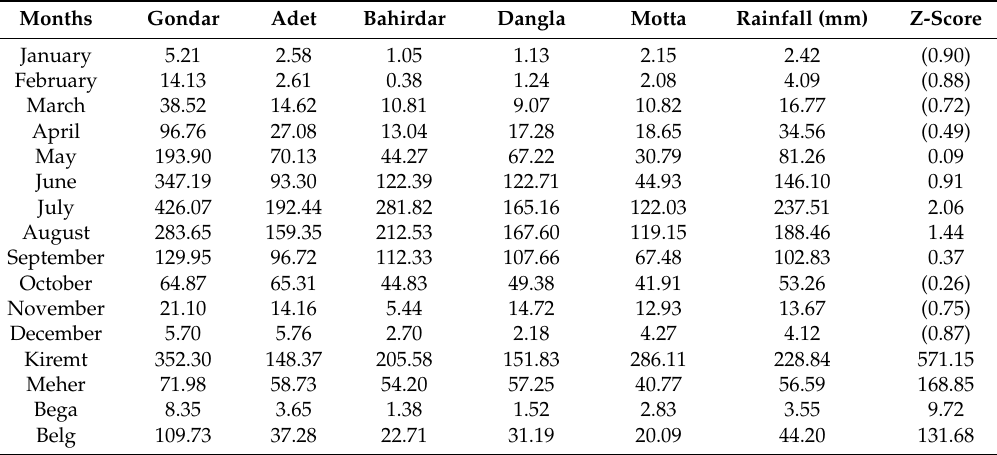
Table 2. Monthly and seasonal rainfall across stations.